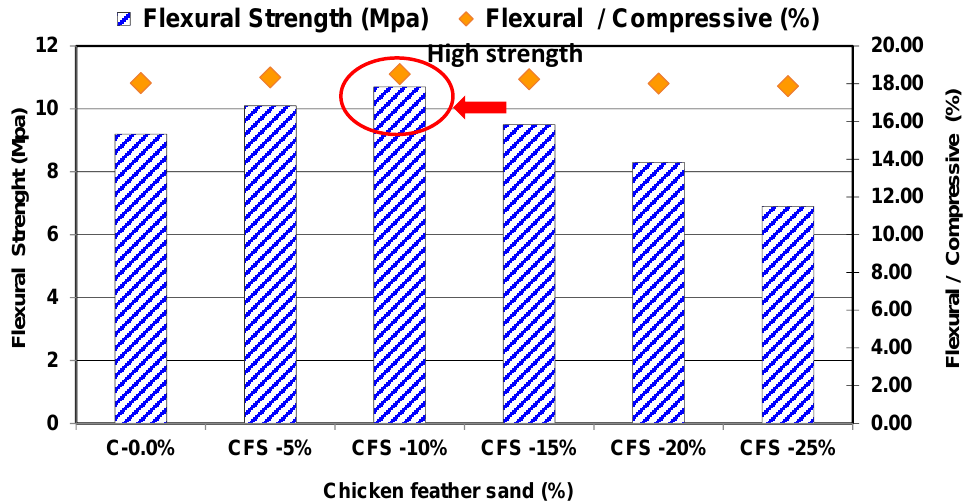
Figure 11. The relationships between flexural strength and flexural/compressive strength (%) de- pending on the replacement percentage.